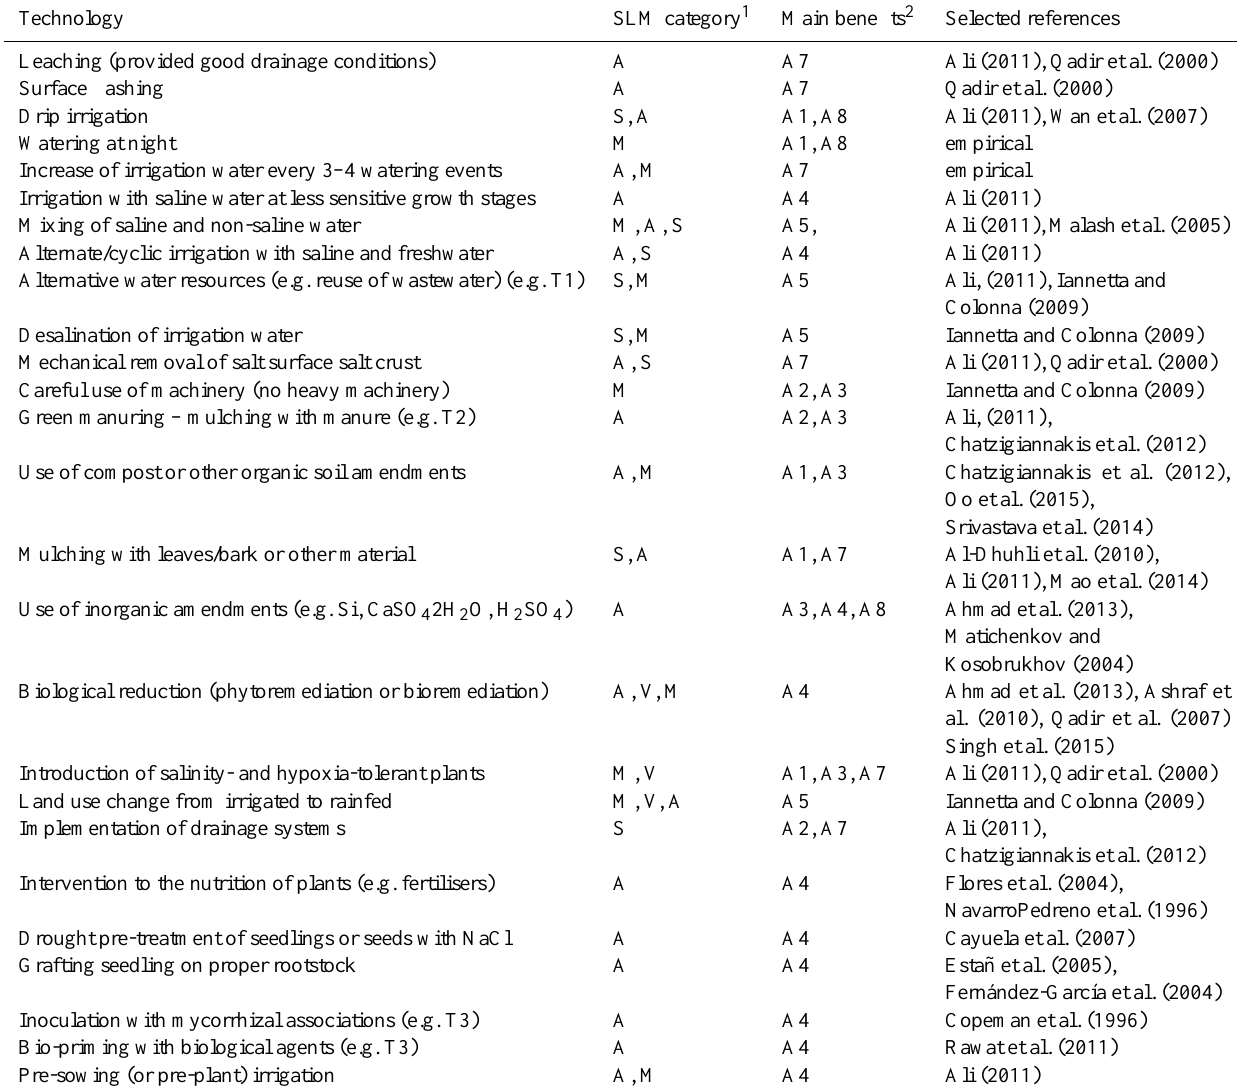
Table 2. List of amelioration technologies for soil salinisation.